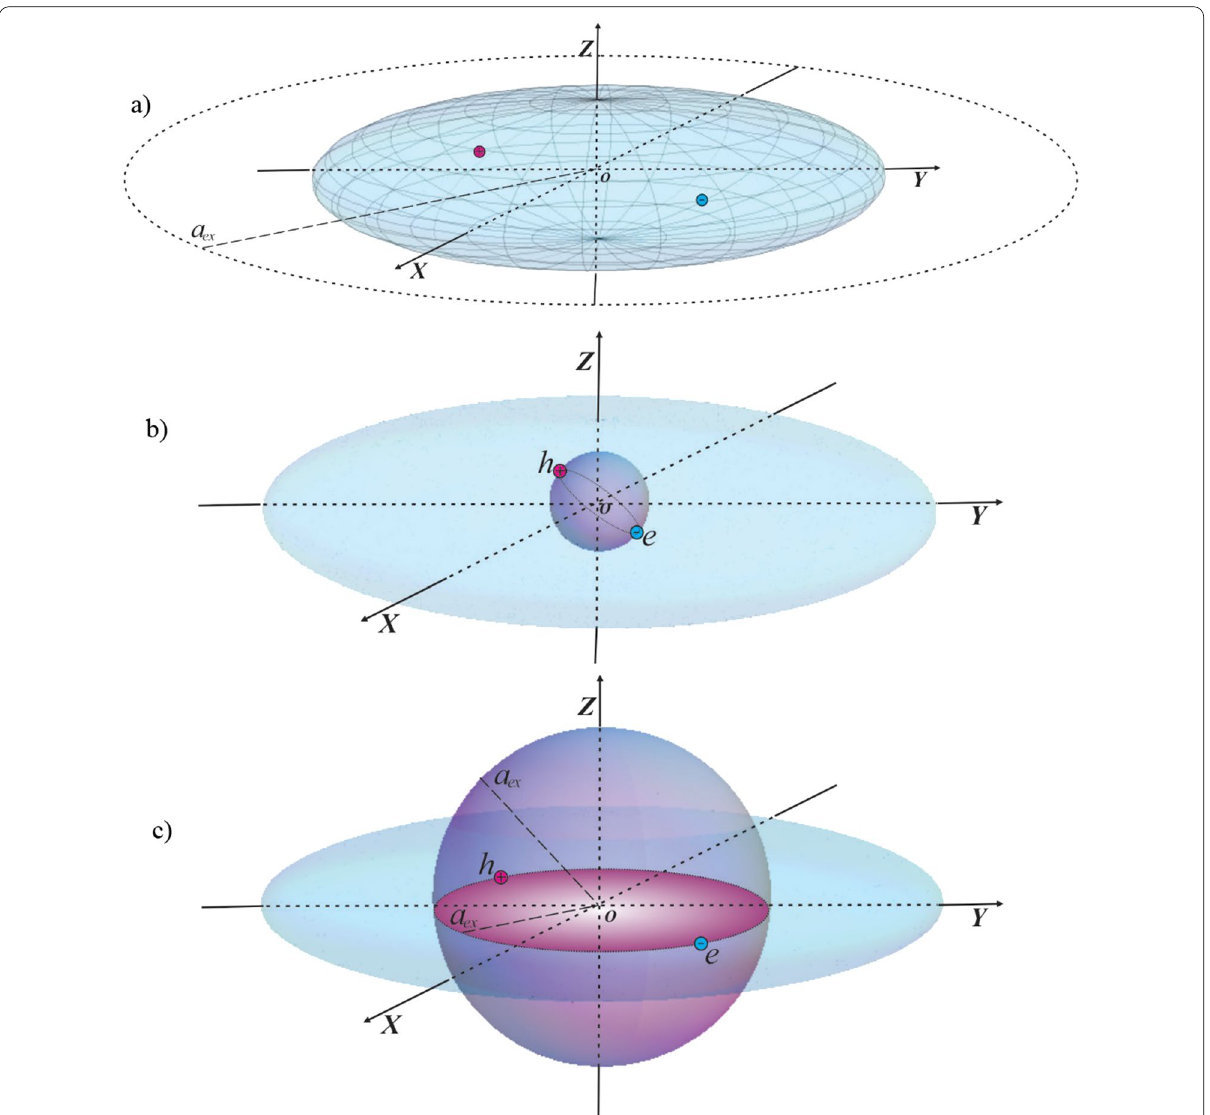
Fig. 1 Strongly flattened ellipsoidal QD: ( a ) realization of the strong quantum confinement regime, when the condition a ex >> a >> c holds, and the motions of an electron and a hole are quantized separately, ( b ) realization of the weak quantum confinement regime, when the condition c >> a ex holds, and the motion of a 3D exciton is quantized, ( c ) realization of the intermediate quantum confinement regime, when the condition a >> a ex >> c holds, and the motion of a 2D exciton is